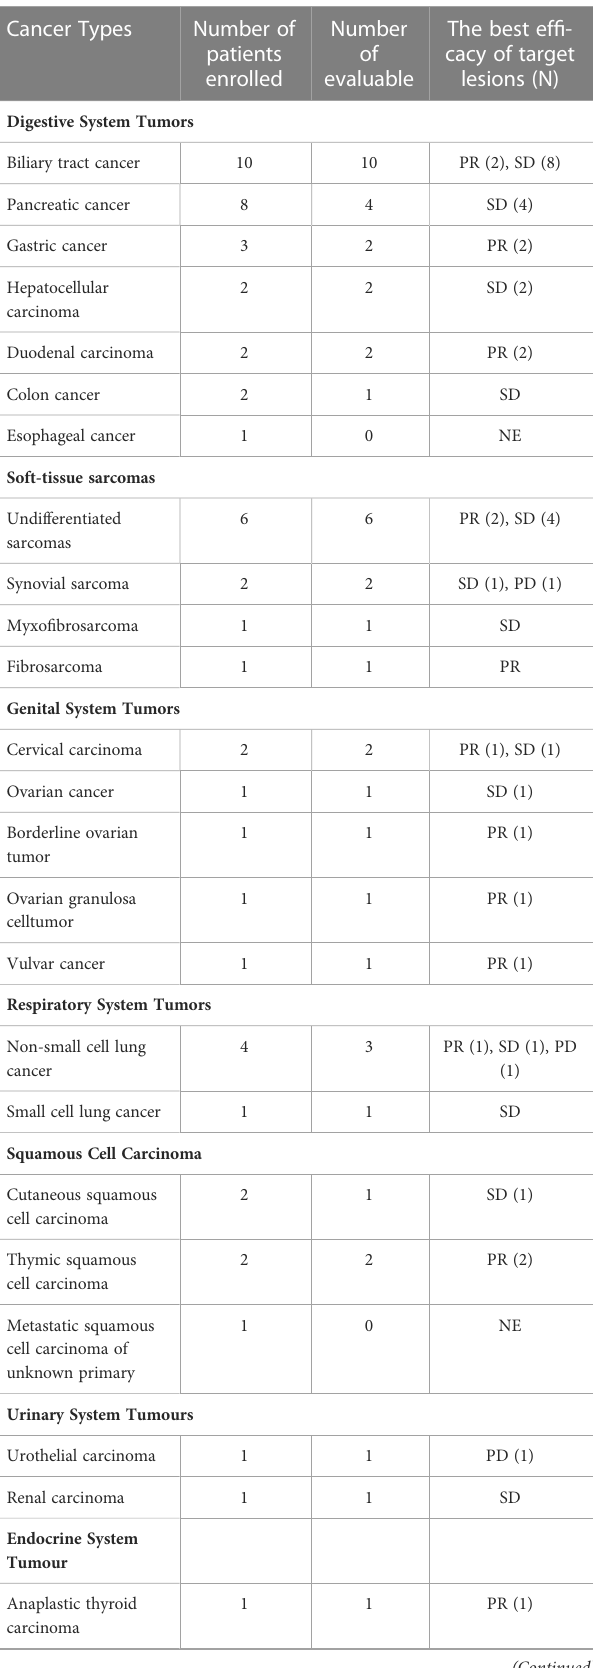
TABLE 3 Ef fi cacy of each cancer